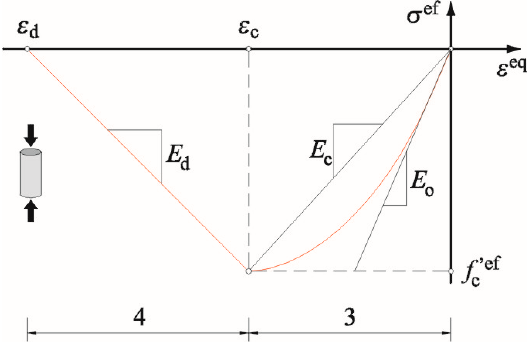
Figure 4. Compressive stress–strain relationship.